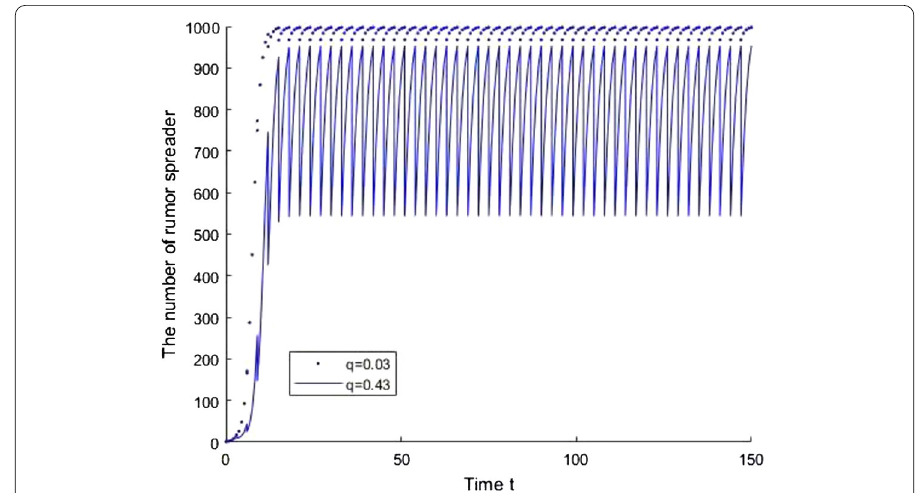
Figure 10 When q < q thr , the evolution graph with different q of x ( t ) are in a periodic solution